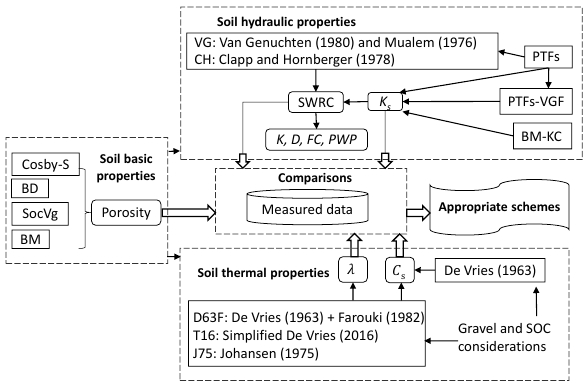
Figure 2. Flowchart depicting the implementation of different schemes of porosity and SHP and STP by using in situ basic soil properties data. Dashed boxes indicate various categories of param- eterization schemes and the comparisons with the measurements. Block arrows show the main data flow for comparisons. Single ar- rows represent the steps that occur internally for each part or con- nect various parts. Rectangles represent schemes. Rounded rectan- gles denote porosity and SHP and STP parameters. K and D repre- sent hydraulic conductivity and diffusivity,